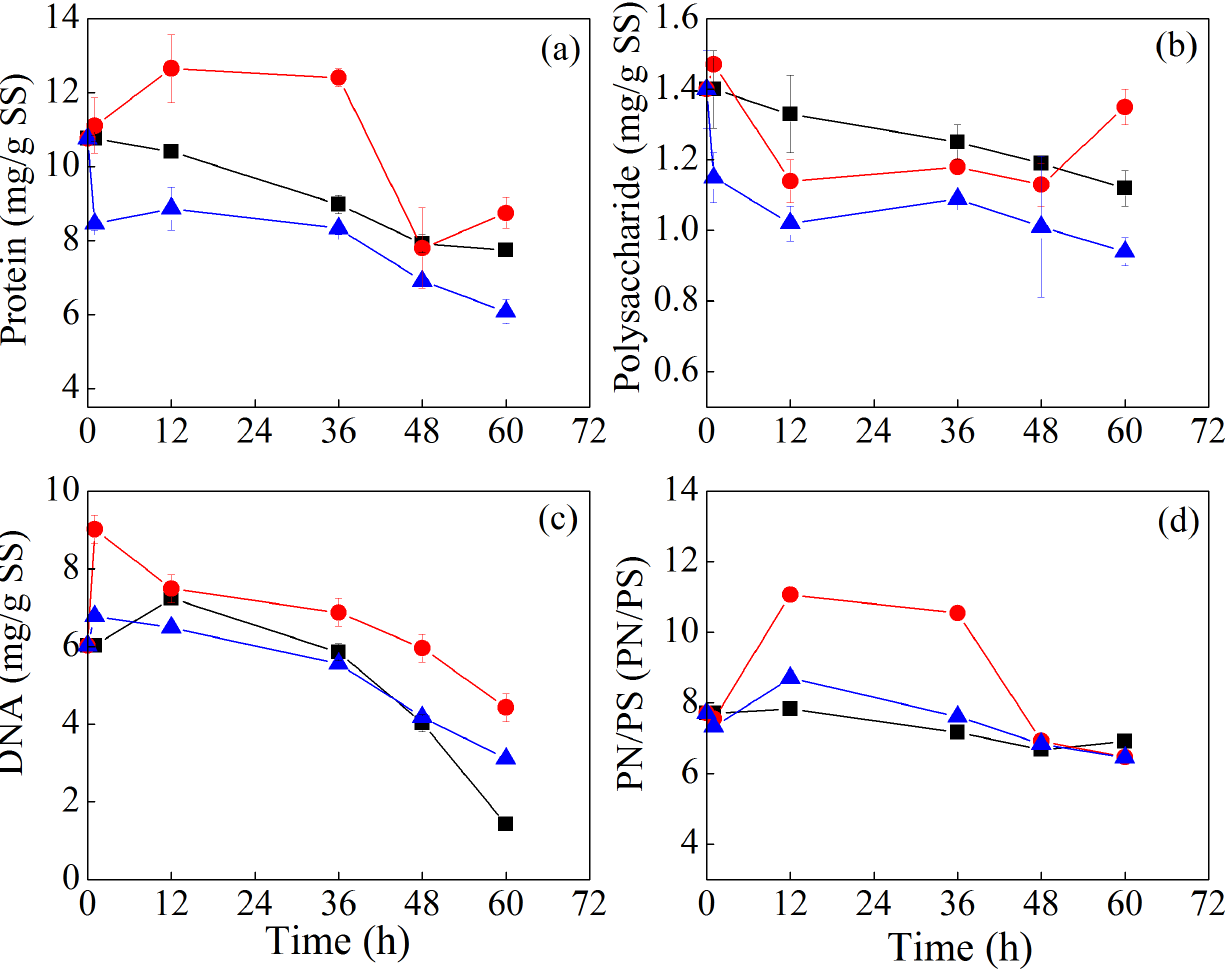
Figure 3. Variation of the content of protein (a), polysaccharide (b) and DNA (c), and PN/PS (d) in LB-EPS during sludge bioleaching process. (PN/PS: protein/polysaccharide) ( & CK1, # CK2, g A.t + A.f ).